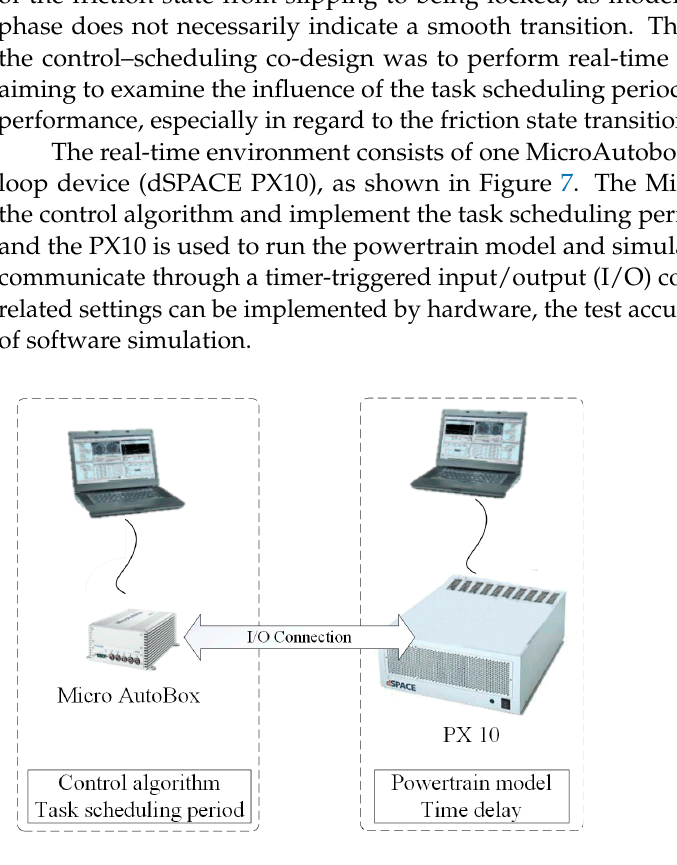
Figure 7. Real-time test platform.